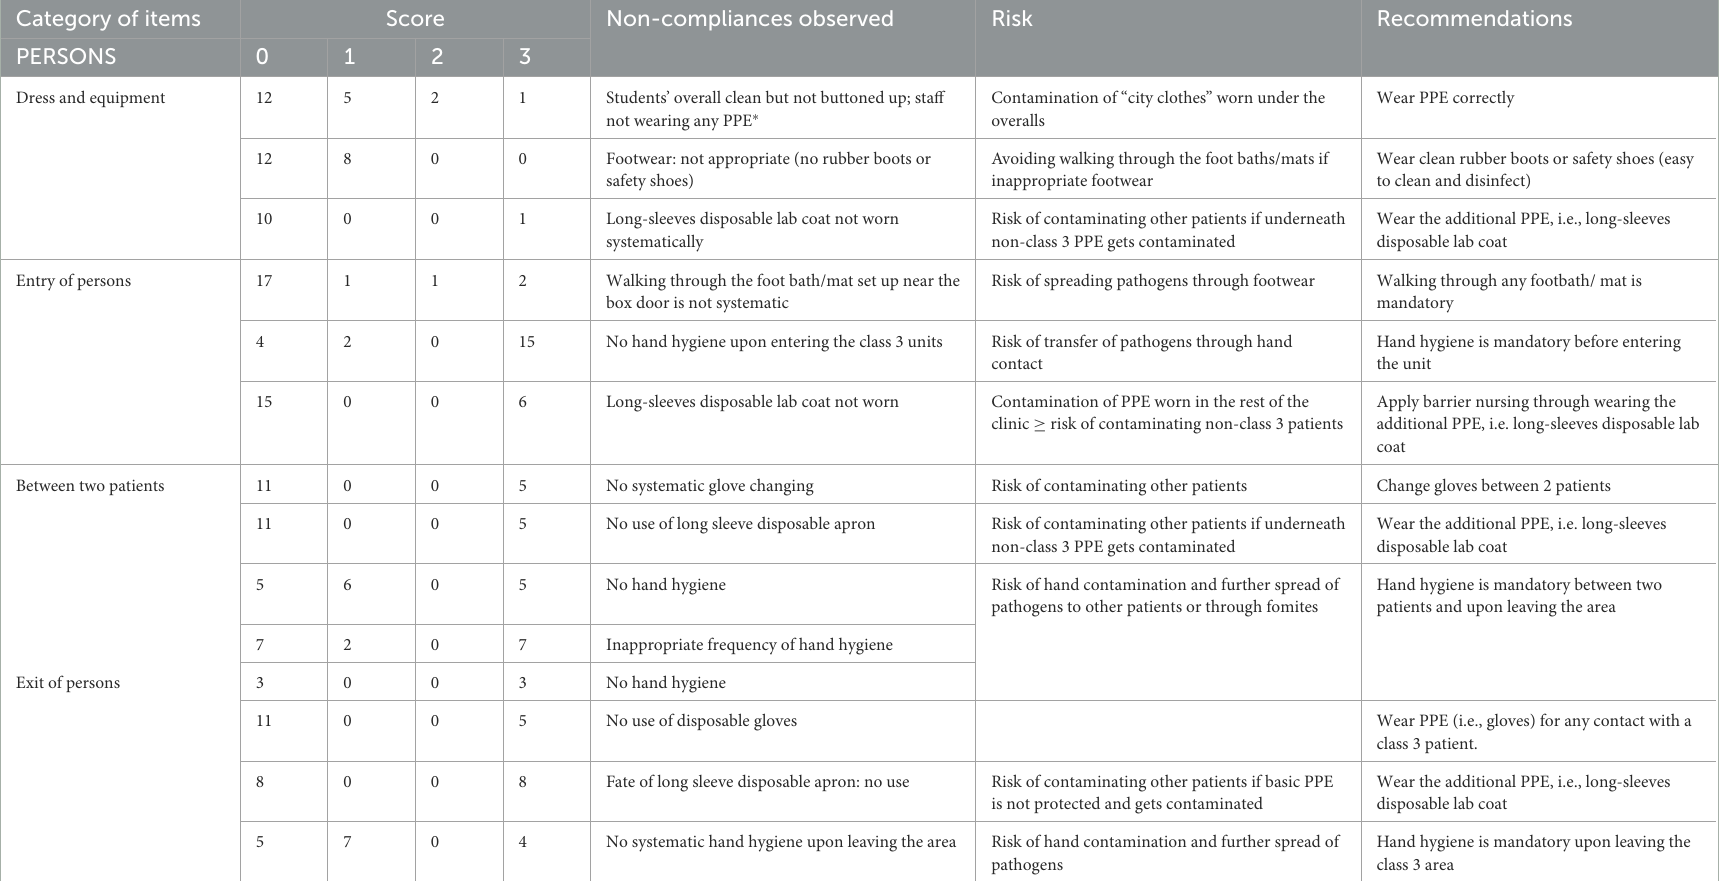
TABLE 2A Biosecurity deficiencies observed when performing the internal audit in the Equine class 3 area—category “PERSONS”. Category of